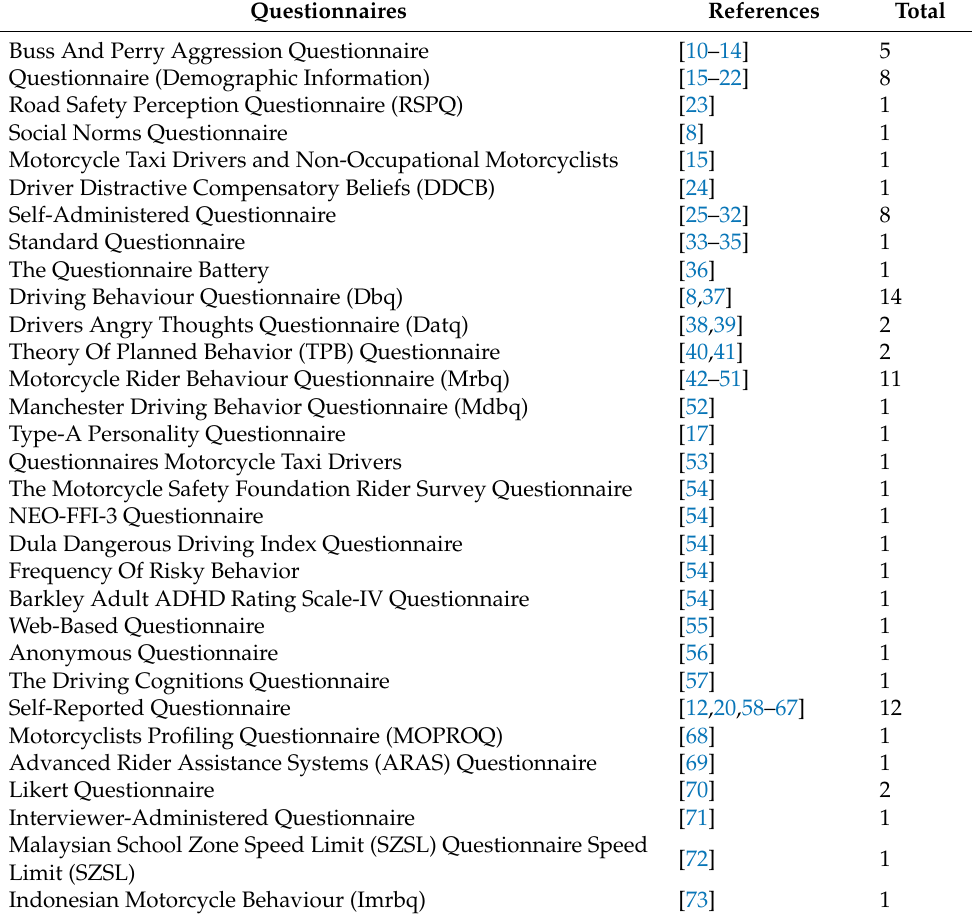
Table 2. Questionnaire